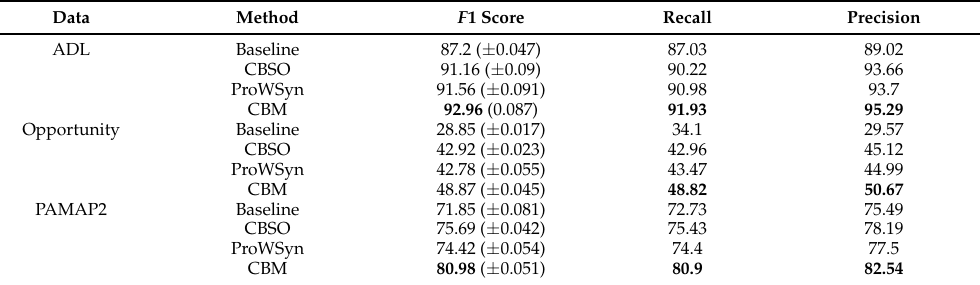
Table 6. Cluster-based results. Comparing the performance of MLP using CBM, CBSO, and ProWsyn on multiple datasets. The reported mean of F 1 scores and ( ± standard deviation), recall, and precision are obtained from 30 repetitions. The F 1 score, recall, and precision are in %. Highest scores are shown in bold.